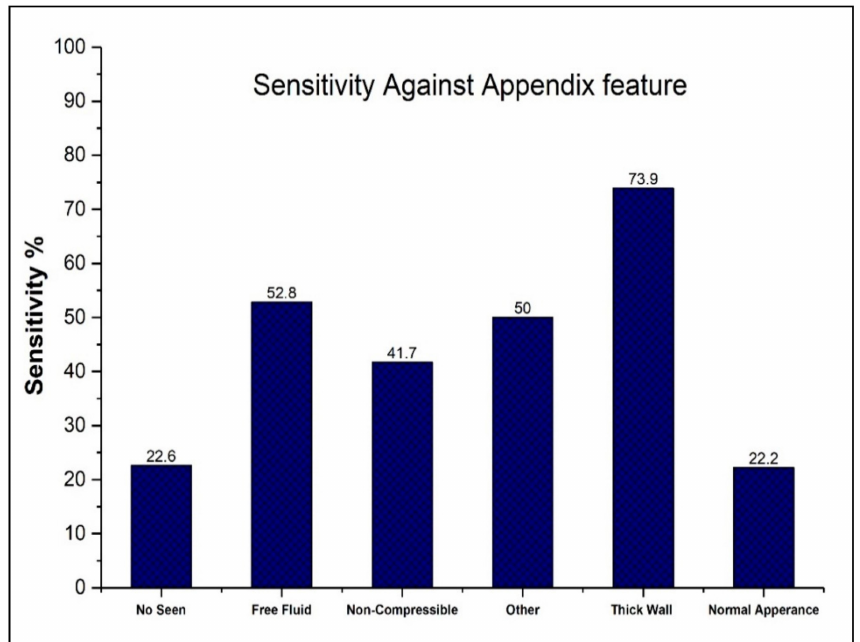
Figure 1. Sensitivity readings against image